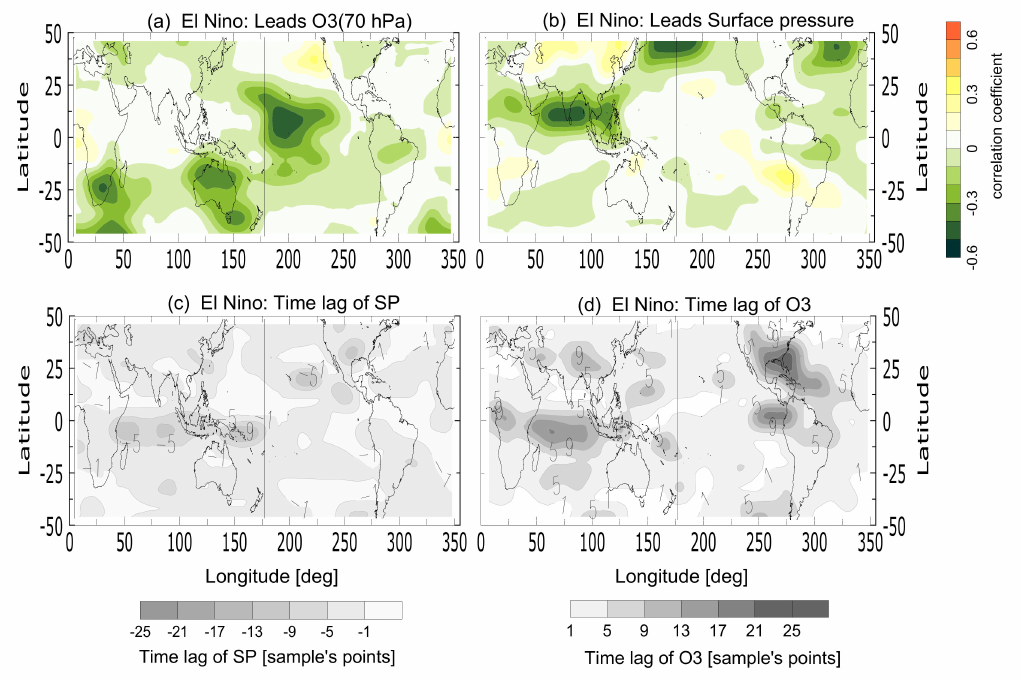
Figure 3. Maps of lagged cross-correlation between the ozone at 70 hPa and sea level pressure (coloured shading in top panels), calculated for El Niño composite over the period 1900–2019. ( a ) O 3 influence on pressure; ( b ) sea level pressure influence on ozone. Bottom panels illustrate the time delay of pressure to ozone forcing ( c ), and ozone response to pressure variations ( d ).